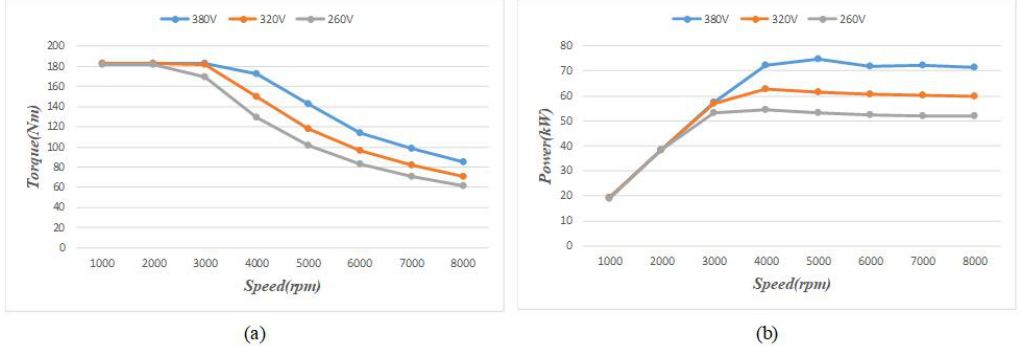
Figure 10. Experiment results of ( a ) maximum torque and ( b ) power using the proposed method (380, 320, and 260